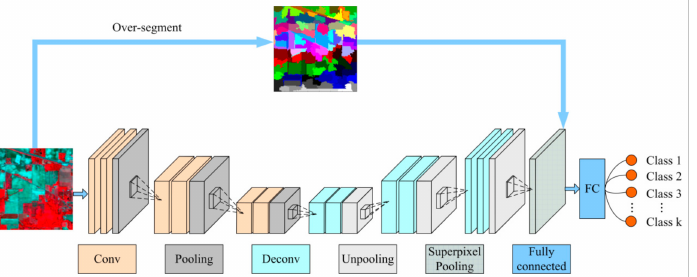
Figure 1. The framework of the proposed superpixel pooling convolutional neural network with transfer learning (SP-CNN) method. This scheme consists of down-sampling (convolution and pooling), up-sampling (deconvolution and up-pooling), superpixel pooling and a fully connected